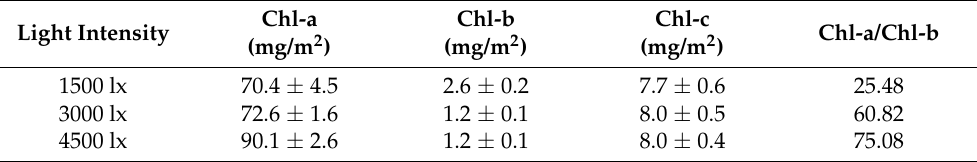
Table 1. The concentrations of chlorophyll a, b and c in the phototrophic biofilms. Light Intensity